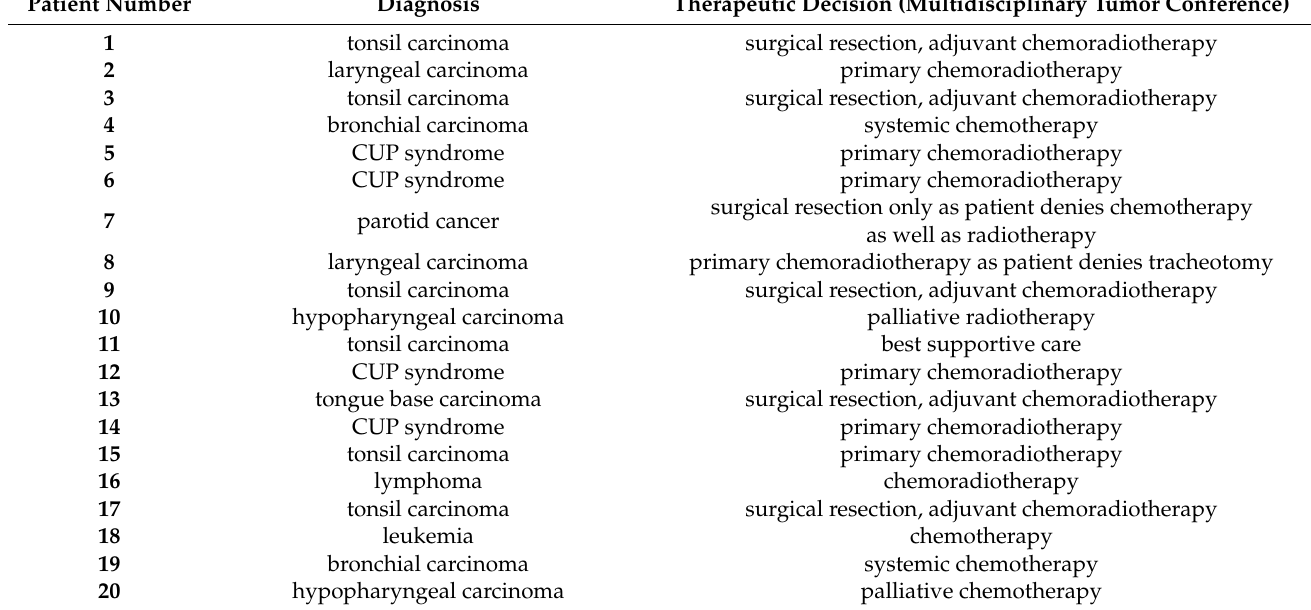
Table 4. Excerpt of the further therapeutic course of the 30 included patients based on the decision of the institutional multidisciplinary tumor